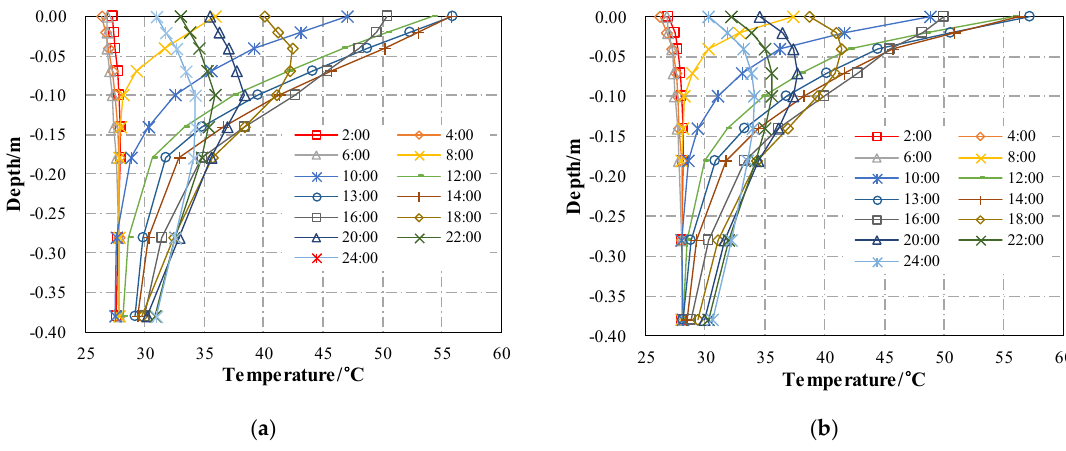
Figure 12. Asphalt pavement temperature and depth at different times: ( a ) Conventional asphalt pavement; ( b ) Cooling asphalt pavement with CASMA thermal insulation layer.